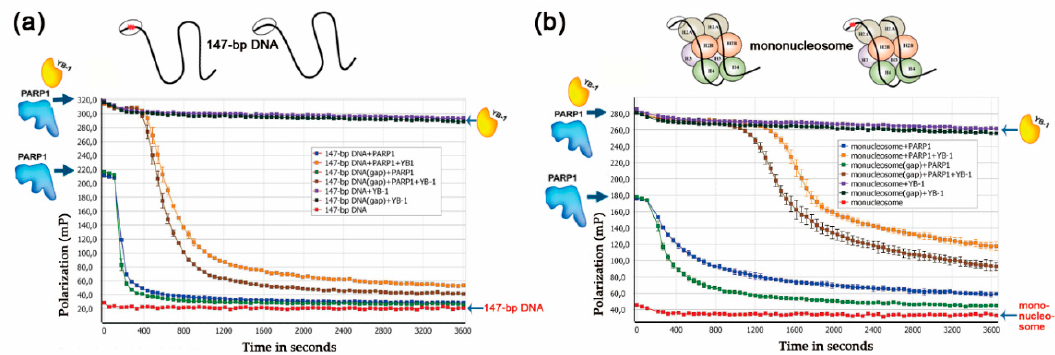
Figure 5. YB-1 modulates the dissociation of the autoPARylated PARP1 from 147 bp DNA substrates and mononucleosomes. ( a ) Comparative analysis of dissociation curves of the protein–DNA complex after protein PARylation in the presence of a 147 bp DNA substrate. The reaction mixtures contained 100 nM PARP1, 4 µM NAD + , 1600 nM YB-1 (where indicated), and 100 nM undamaged or damaged 147 bp DNA (gap). ( b ) Comparative analysis of dissociation curves of the protein–DNA complex after protein PARylation in the presence of a mononucleosome substrate. The reaction mixtures contained 100 nM PARP1, 4 µM NAD + , 1600 nM YB-1 (where indicated), and 100 nM undamaged or damaged mononucleosome (gap).